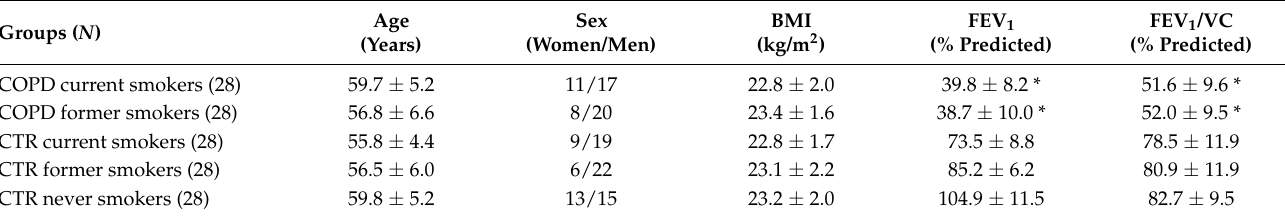
Table 1. Characteristics of the analyzed